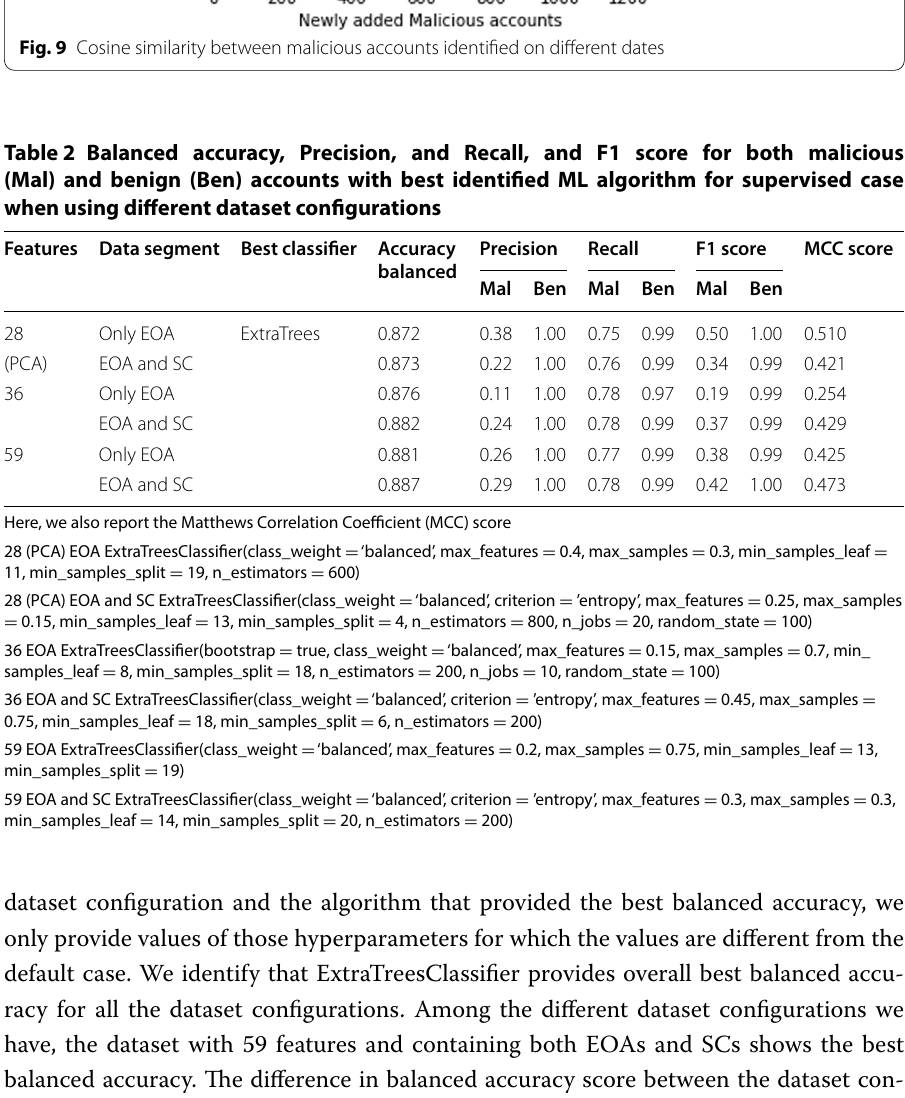
figurations when 36 and 59 features are used is only 0.5% for both when we consider only EOAs and all the accounts, respectively. Given such results, we show that correlated features do not provide much gain and can be removed without the loss of accuracy.